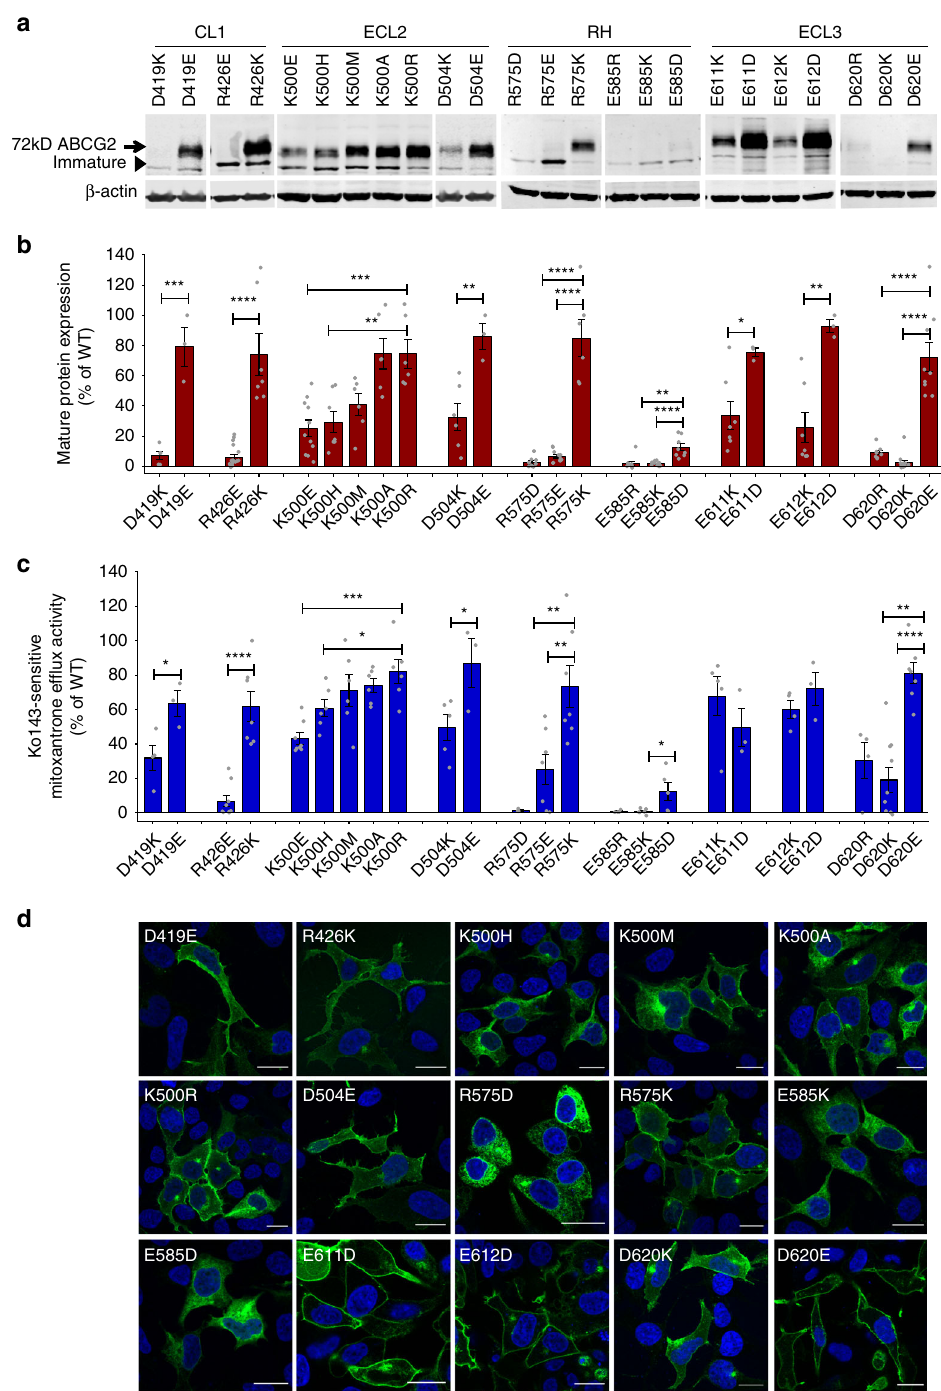
Fig. 2 Functional analysis of the extracellular ABCG2 residues. Residues in the extracellular ABCG2 regions were subjected to mutational analysis, followed by functional expression in HEK293 cells. a Immunodetection of ABCG2 variants after transient transfection into HEK293 cells for 2 days is shown. β -Actin was used as a loading control. b Odyssey-based quanti fi cation of immunoblots from several independent experiments ( n = 3 – 14). ABCG2 signals were individually normalized to β -actin and shown as the percentage of the WT control. Cell-free extracts from HEK293 cells were prepared from the same experiment; immunoblots from different gels are separated by white spaces. c Mitoxantrone ef fl ux is shown for HEK293 cells transfected with ABCG2 variants. Mitoxantrone accumulation was quanti fi ed in the presence and absence of Ko143 inhibitor after incubation for 20 min at 37 °C. Ko143-sensitive mitoxantrone ef fl ux is given as percentage ef fl ux activity relative to WT control. Data are from several independent experiments ( n = 3 – 9). All results are represented as means ± SEM; **** P < 0.0001; *** P < 0.001; ** P < 0.01; * P < 0.1. Gray dots represent values from each independent experiment. d Membrane localization of GFP-tagged ABCG2 mutants was detected by fl uorescence microscopy in the GFP channel (green) as described in Methods. Nuclei were stained with DAPI (blue). Microscopy data are from representative duplicate experiments. Scale bars in microscopy images correspond to 20 µ